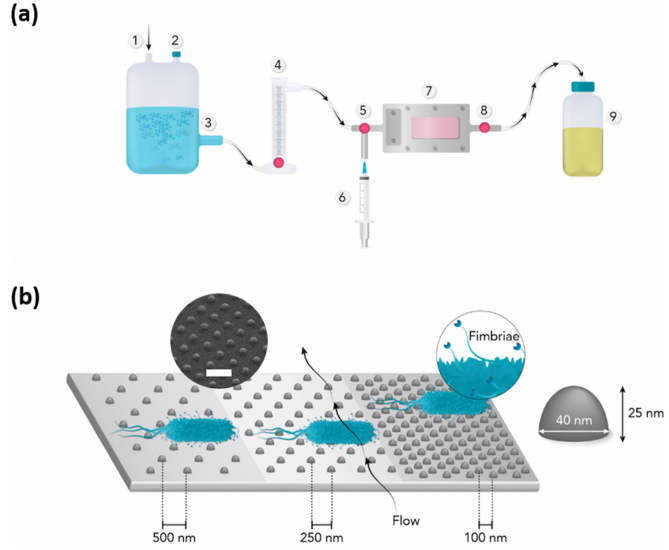
Figure 1. Flow chamber setup ( a ): 1—air supply, 2—air outlet, 3—distilled water tank, 4—flow meter, 5—right valve, 6—syringe input, 7—flow chamber with nanopatterned sample ( n = 191), 8—left